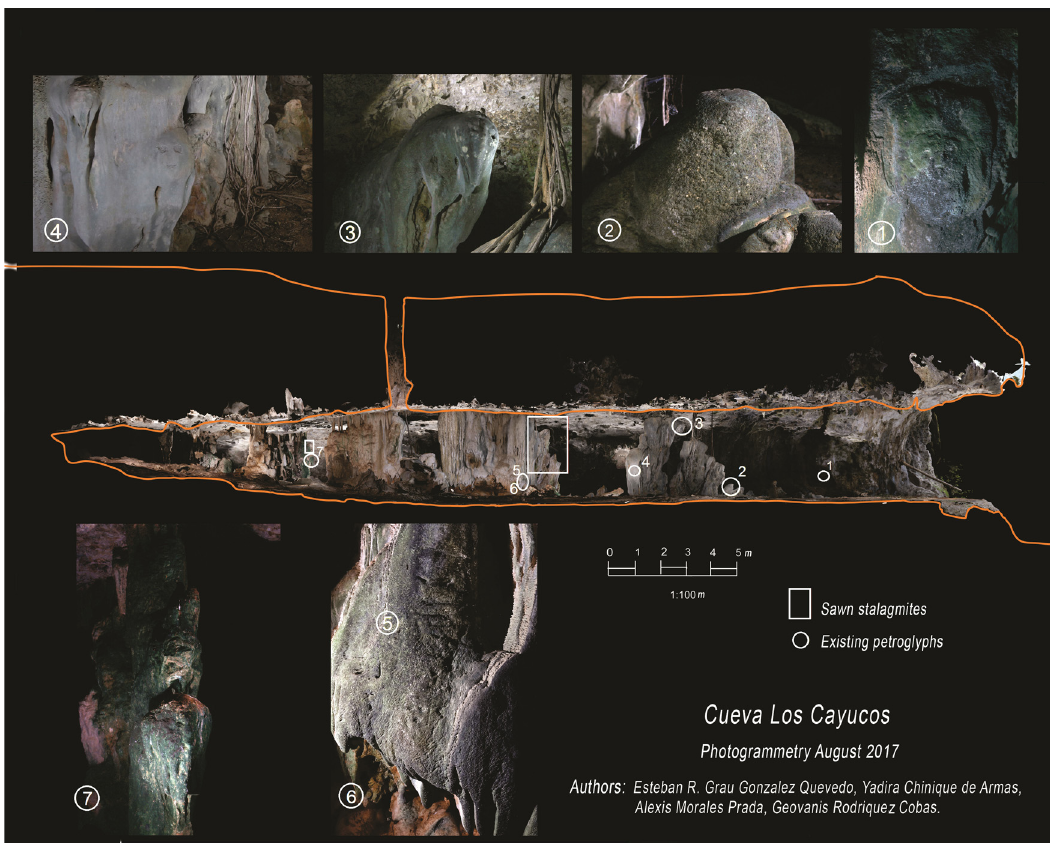
Figure 4: Position of petroglyphs in the Los Cayucos cave